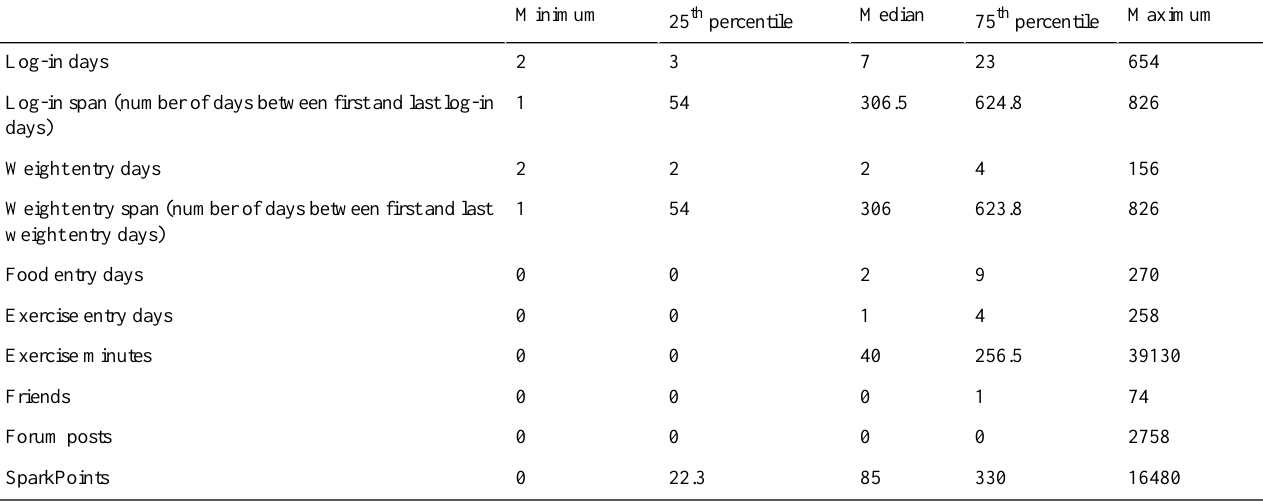
Table 2. Website usage characteristics of final cohort (n=1258).